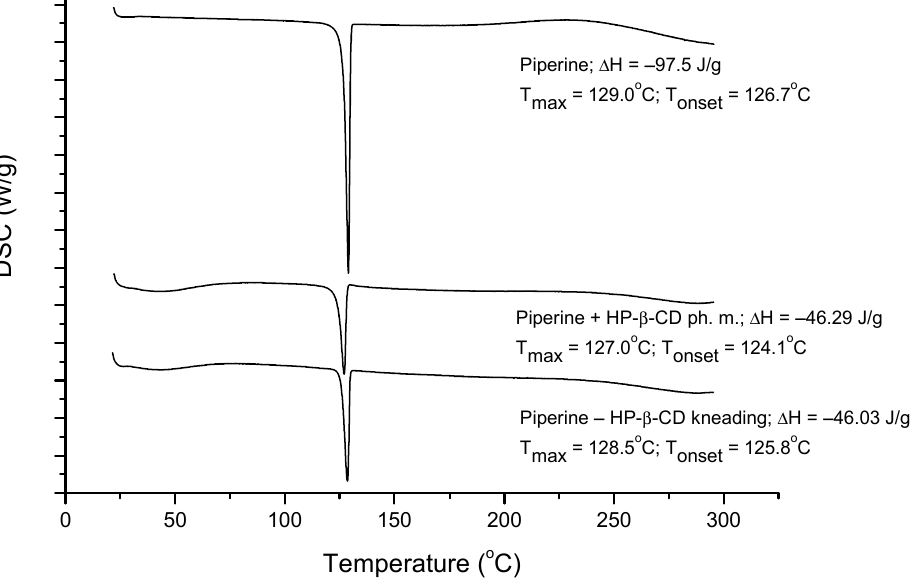
Figure 4. Differential scanning calorimetry (DSC) thermograms of piperine, the mixture with HP- β -CD obtained by kneading method and physical mixture.